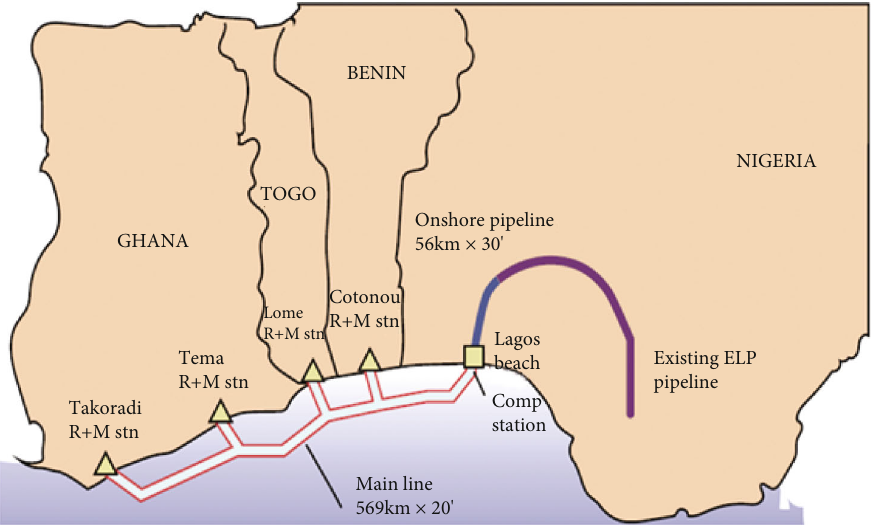
Figure 2: Schematic of the West African Gas Pipeline (WAGP) from Nigeria to Ghana [34].